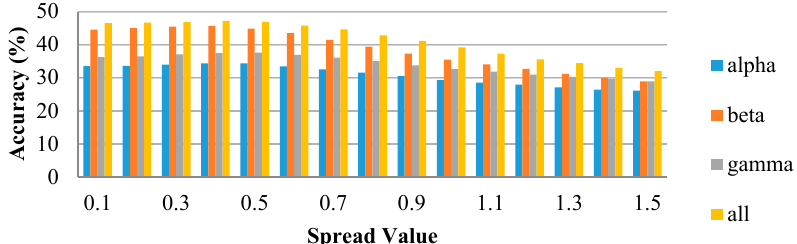
Figure 13. Average classification performance of bispectrum features by varying spread values for the NC group using PNN.